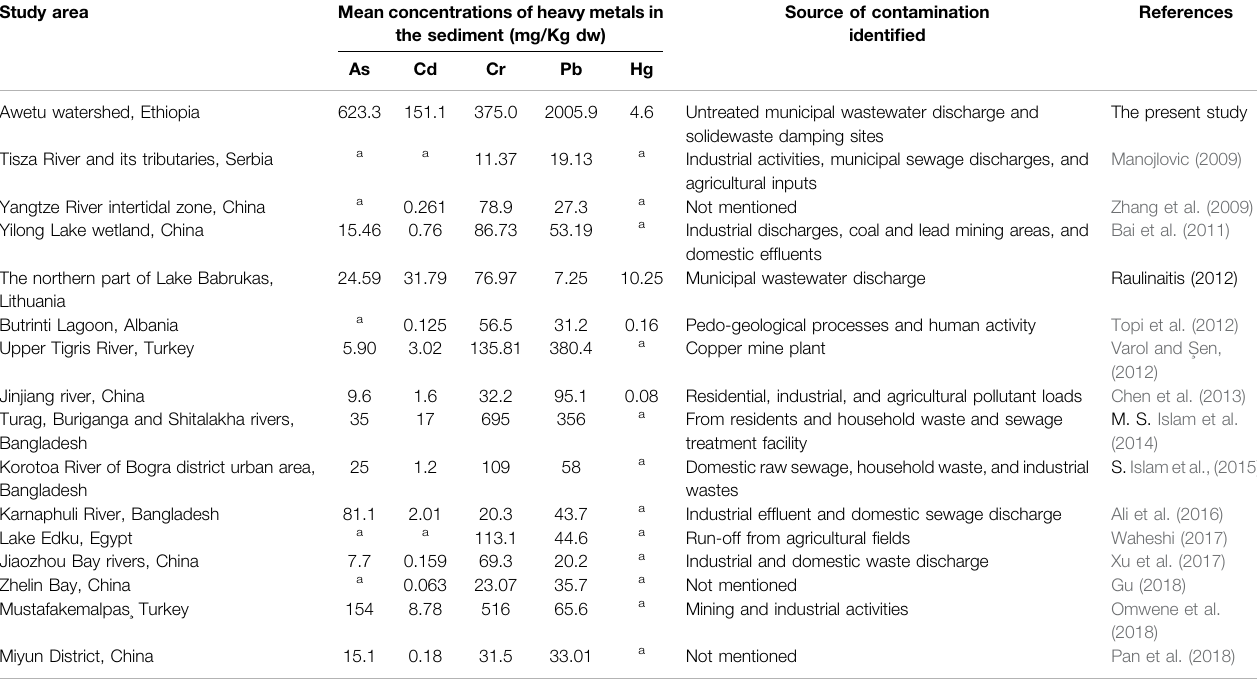
TABLE 7 | Heavy metal concentrations in sediment samples from ou study and from other studies from river